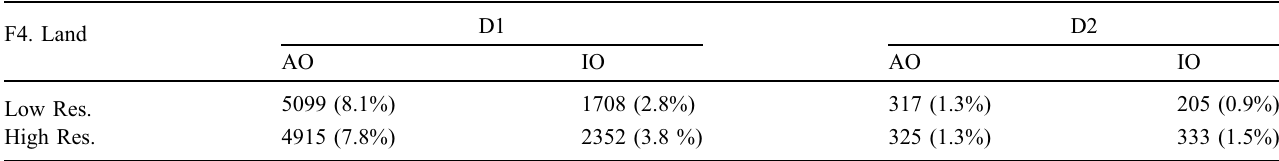
Table 3. Number and percentage (in brackets) of data recorded on land for the different datasets in the Atlantic Ocean (AO) and Indian Ocean (IO).